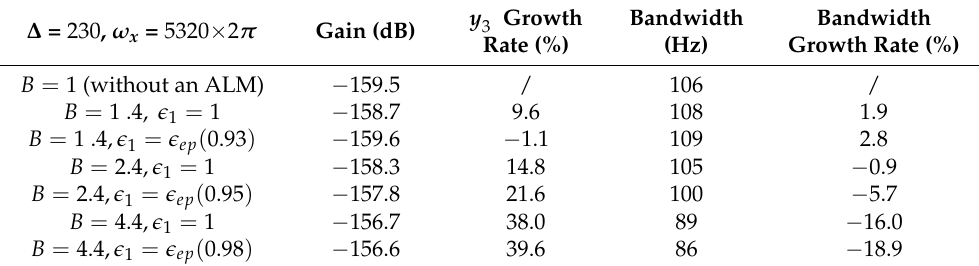
Table 3. Gain and bandwidth of nonlinear micro-gyro under typical